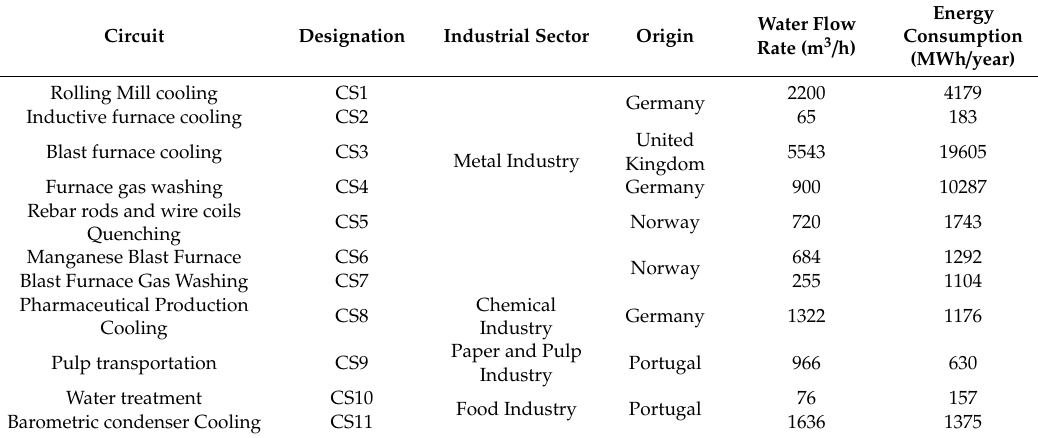
Table 5. Description of WaterWatt case-studies